Question: Does the figure show an increasing or a decreasing trend?
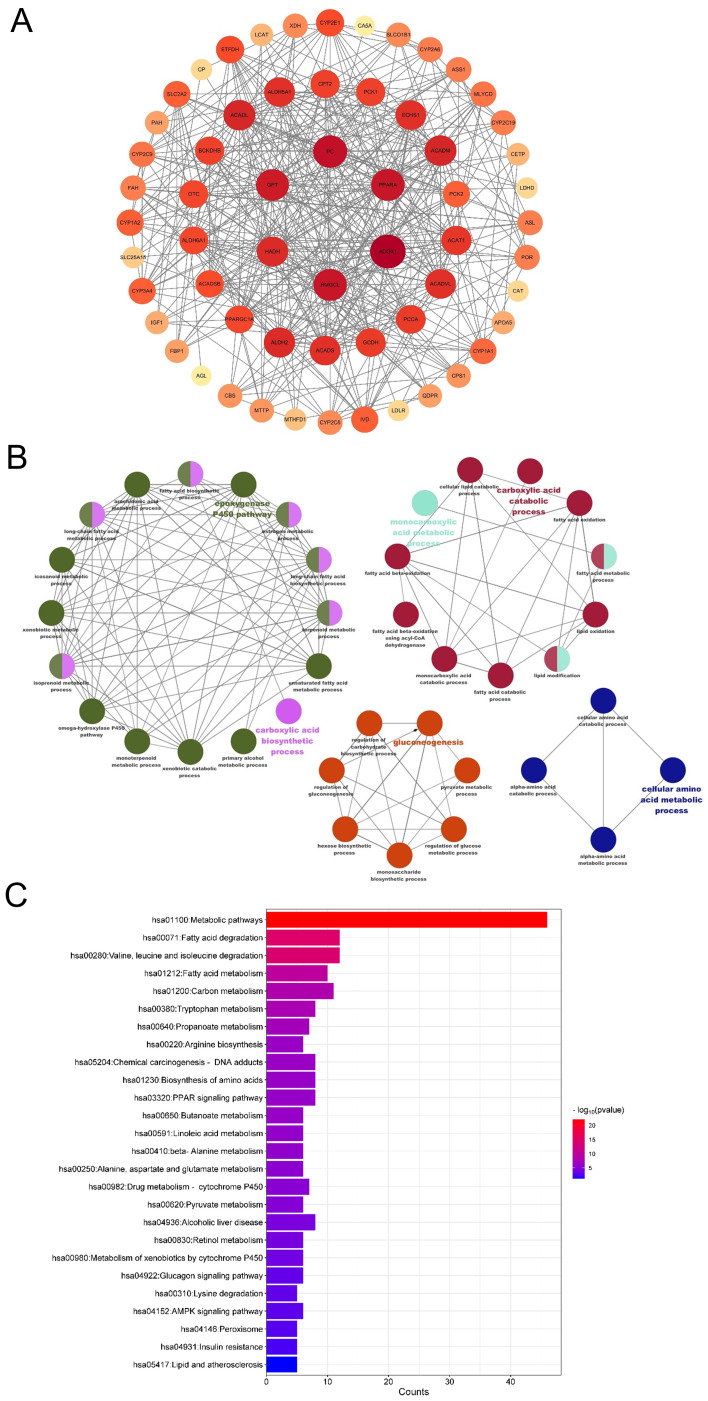
Answer: increasing